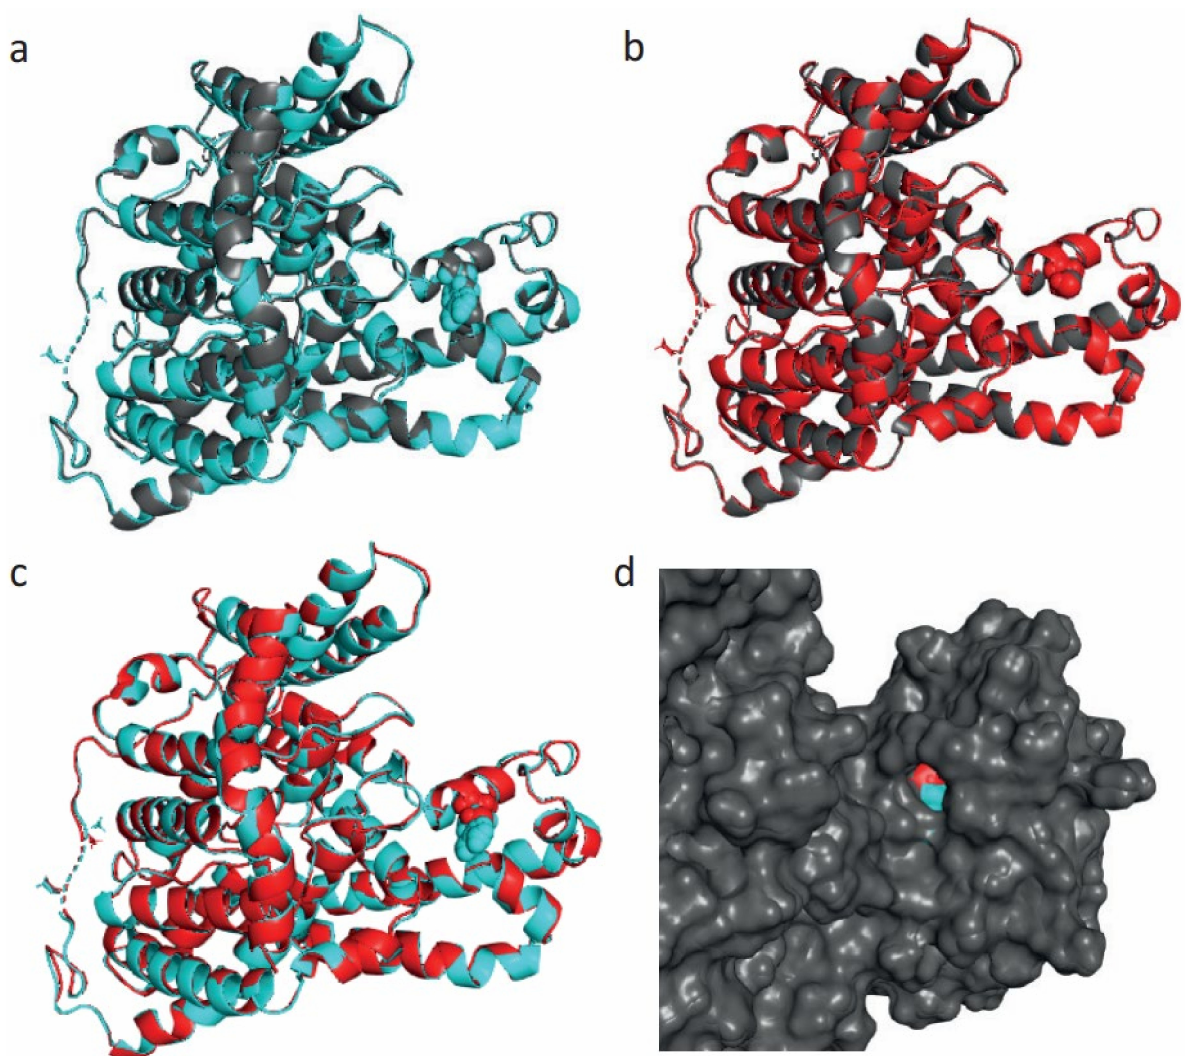
Figure 7. ( a ) Aligned structure of solute carrier family 4, sodium borate transporter, member 11 protein wildtype (891 aa, grey colour) and energy-minimised wildtype (cyan colour). ( b ) Aligned structure of SLC4A11 protein mutant type (grey colour) and energy-minimised mutant type (red colour). ( c ) Aligned structure of energy-minimised solute carrier family 4, sodium borate transporter, member 11 protein wildtype (cyan) and energy-minimised mutant type (red). ( d ) Surface view of aligned structure of energy-minimised SLC4A11 protein wildtype (cyan) and energy-minimised mutant type